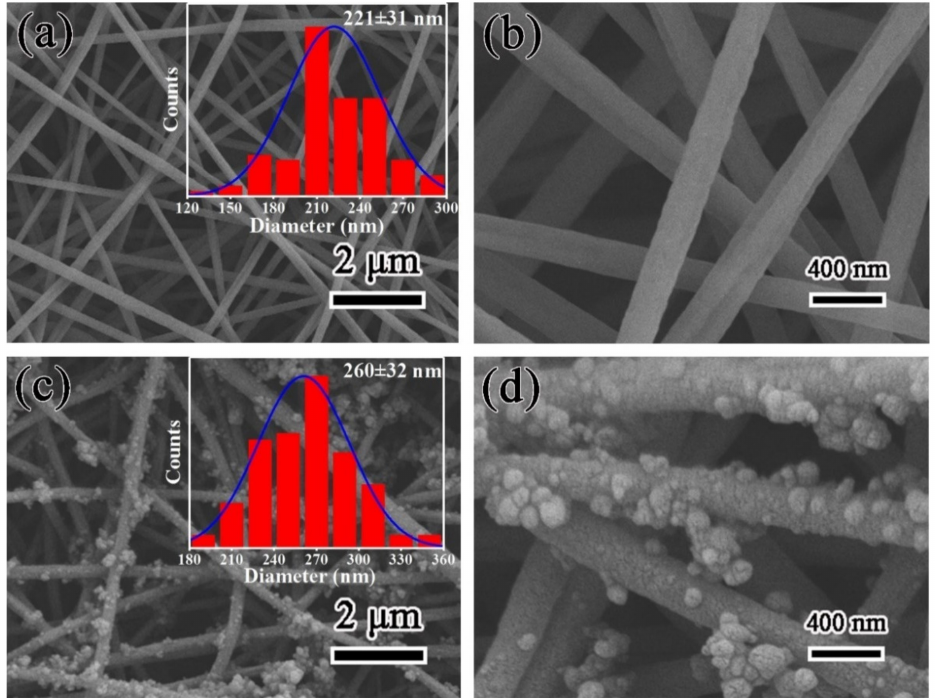
Figure 2. SEM images of PAN ( a , b ) and PDA@PAN nanofirous membrane ( c , d ); the insets in ( a , c ) are histograms of nanofibers diameter